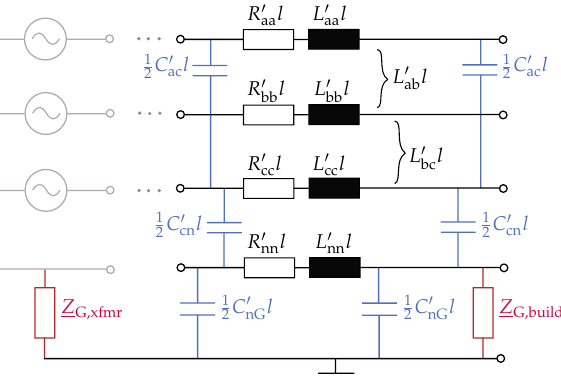
Figure 7. Conceptual sketch of derived line model (line section of length l , mutual inductances, and capacitances